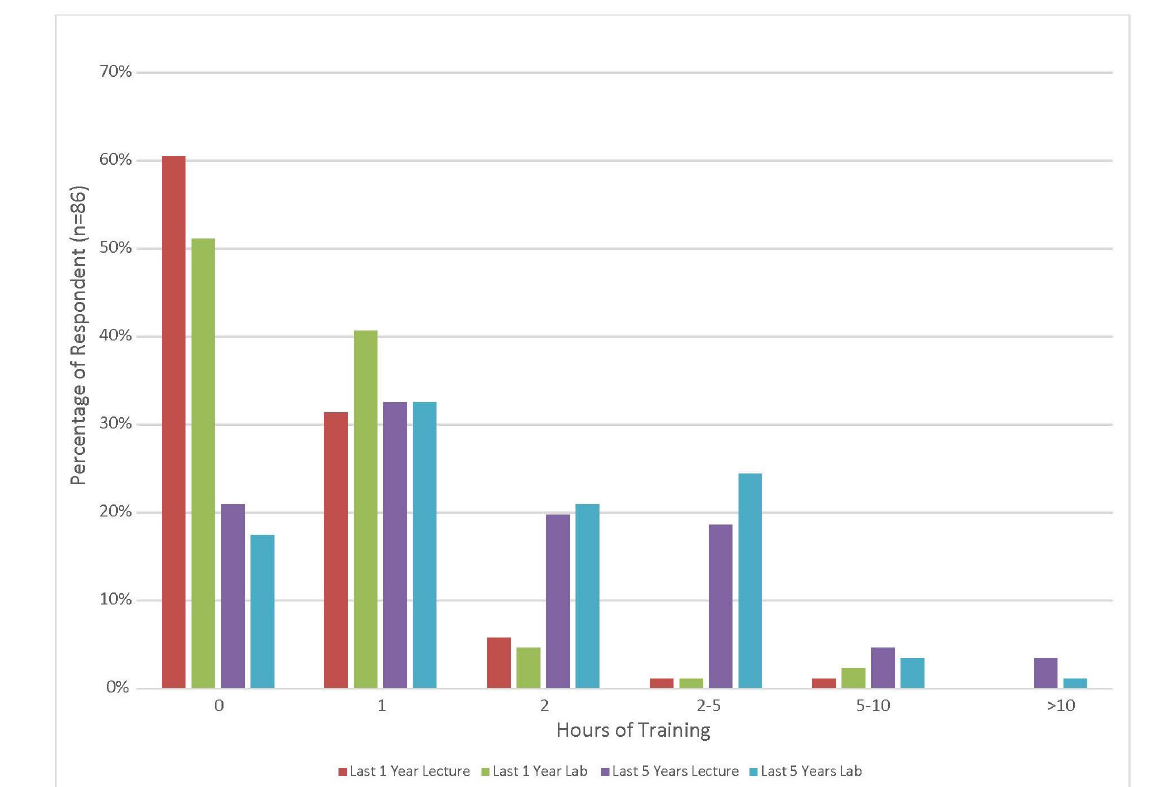
Figure 2. How much and what type of training have you had in prehospital cricothyrotomy in the past 1 year and the past 5